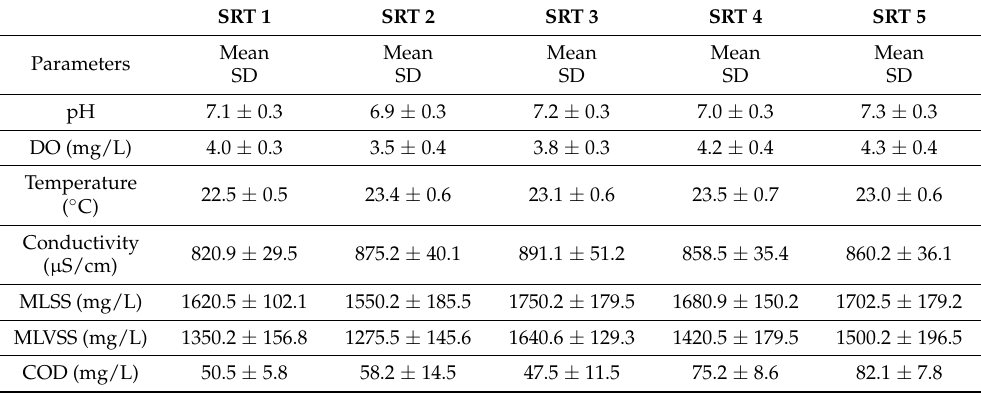
Figure 5. The acclimatization of microorganisms. Table 1. Other monitored parameters during the acclimatization of microorganisms.